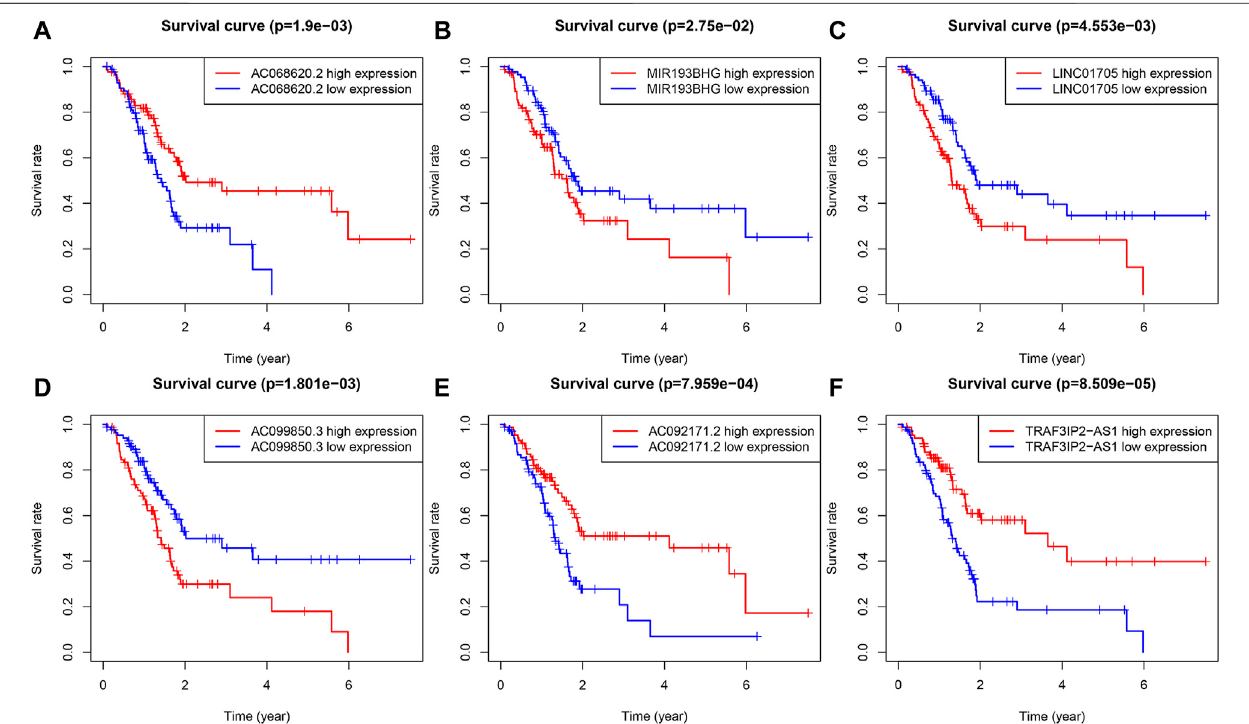
FIGURE 3 | KM survival curves for the six prognostic FRLs. Three FRLs (LINC01705, AC099850.3 and MIR193BHG) were independent unfavorable factors and three lncRNAs (AC068620.2, TRAF3IP2-AS1, and AC092171.2) were independent favorable factors for PAAD.